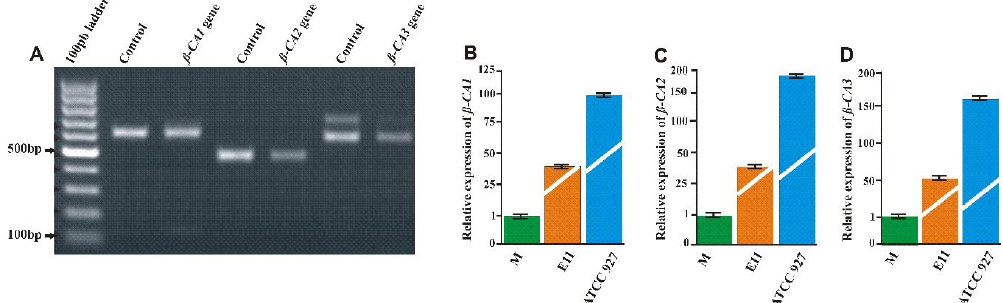
Figure 8. Expression analysis of β -CAs from Mmar : ( A ) The qualitative expression analysis of Mmar β -CA genes showed the presence of all three β -CAs in the ATCC 927 strain. Genomic DNA was used as a positive control. ( B – D ) Relative expression analysis of three β -CA genes from the three strains of Mmar using RT-qPCR